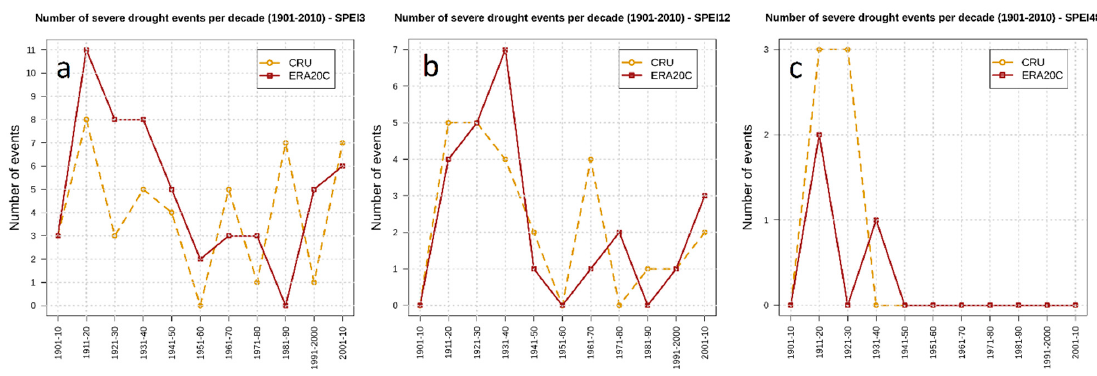
Figure 7. Time series of severe drought events per decade in the ESP region, for ( a ) 3-, ( b ) 12- and ( c ) 48-month SPEI. The red solid line represents events obtained from ERA20C reanalysis and the dashed yellow line represents events from the observed data (CRU).